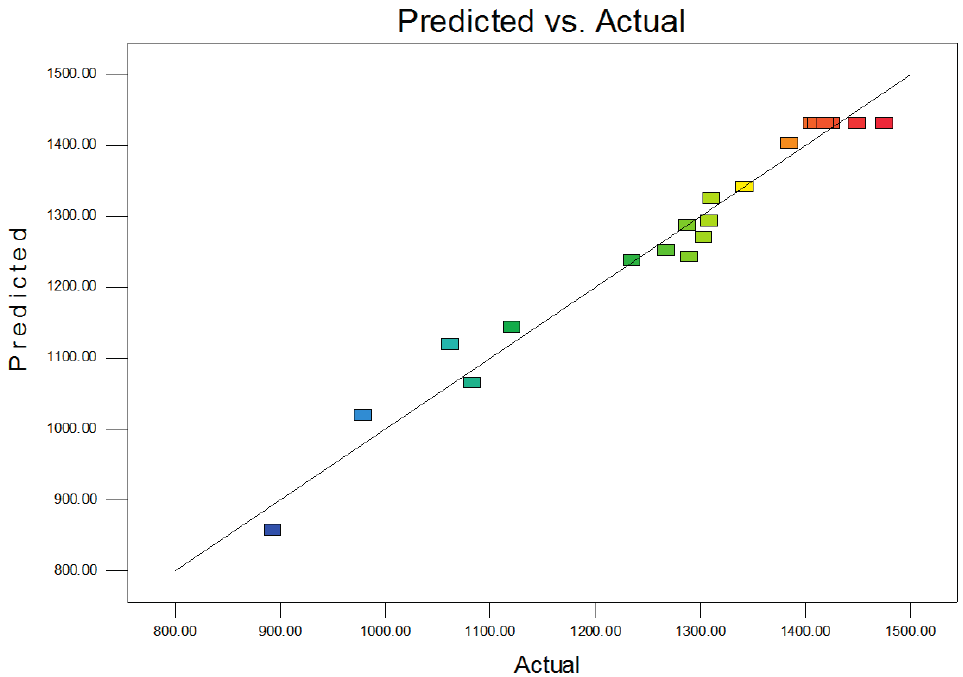
Figure 1. Predicted versus actual values of the response